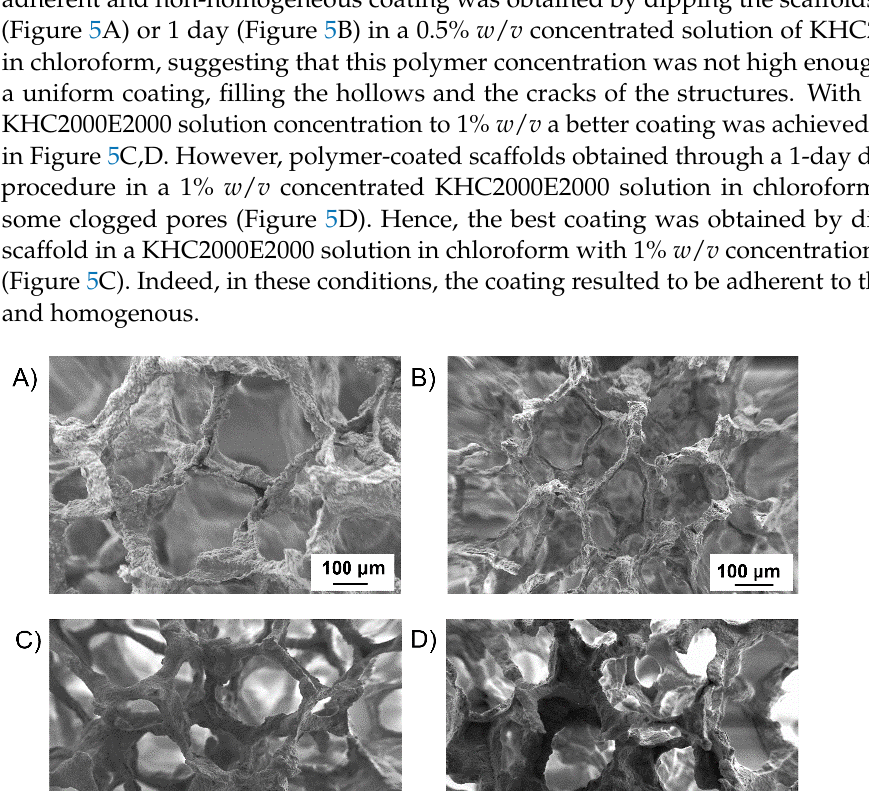
Figure 6. SEM images of a BG scaffold coated in a KHC2000 solution in chloroform with 1% w / v ( A ) or 0.5% w / v ( B ) concentration through a 1-min dip-coating procedure. 3.4. Investigation of Polymer / BG Adhesion To study the interactions occurring between each type of polymer and the scaffold, 45S5 Bioglass ® pellets were produced and coated with the same procedure previously op- timized for scaffolds. Then, the cross-sections of the coated pellets and BG pellets as such (control) were analyzed by SEM. The obtained images allowed a qualitative analysis of the interactions occurring between the polymer and the 45S5 Bioglass ® pellet (Figure 7). The polymeric coating obtained with PCL appeared as a thin poorly adherent film, whereas pellets coated with either KHC2000 or KHC2000E2000 revealed a more adherent coating. This different behavior could be ascribed to the formation of H-bonds between the N-H groups of urethane and urea bonds and the Si-O-Si groups exposed on the 45S5 Bioglass ® pellet surface.